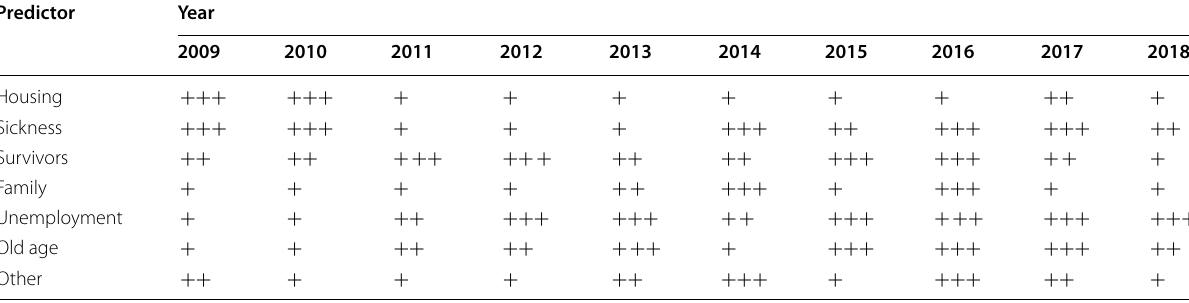
a importance of a predictor, “ Source Own calculations